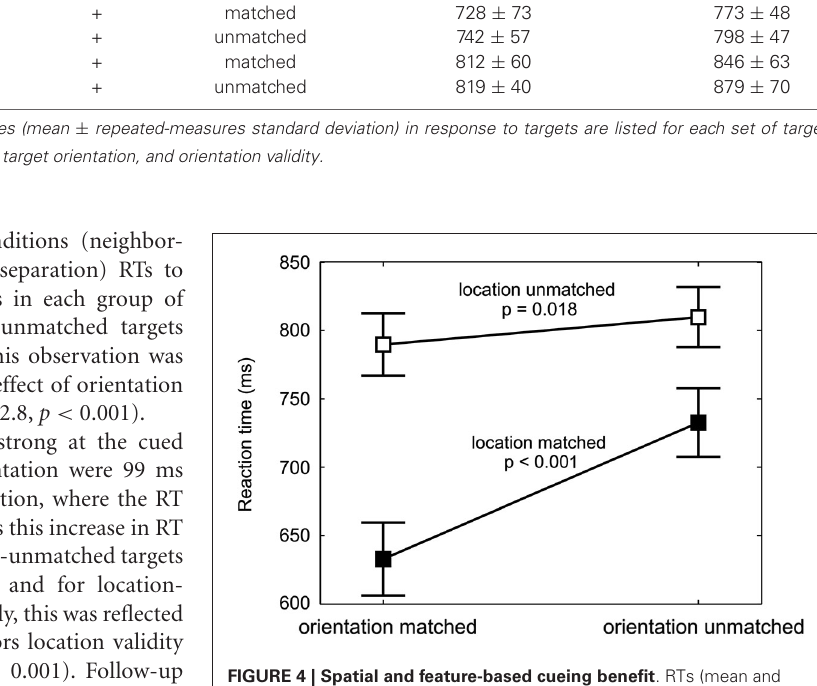
FIGURE 4 | Spatial and feature-based cueing benefit . RTs (mean and repeated-measures 95% confidence intervals, pooled across cue-location groups and target orientations) are shown for each combination of location validity and orientation validity. The values for targets with different orientation validities but same location validity are connected (filled data points for location-matched, empty data points for location-unmatched targets). At both, the cued and at the uncued location, a significant decrease in reaction time from orientation-unmatched to orientation- matched targets is found, with a larger effect for location-matched